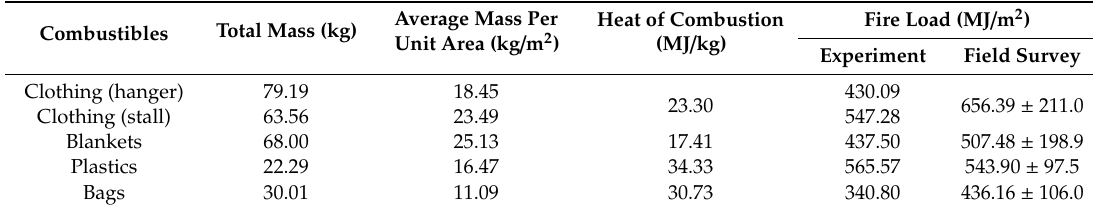
Table 1. Summary of experimental conditions of major combustibles considered in the present